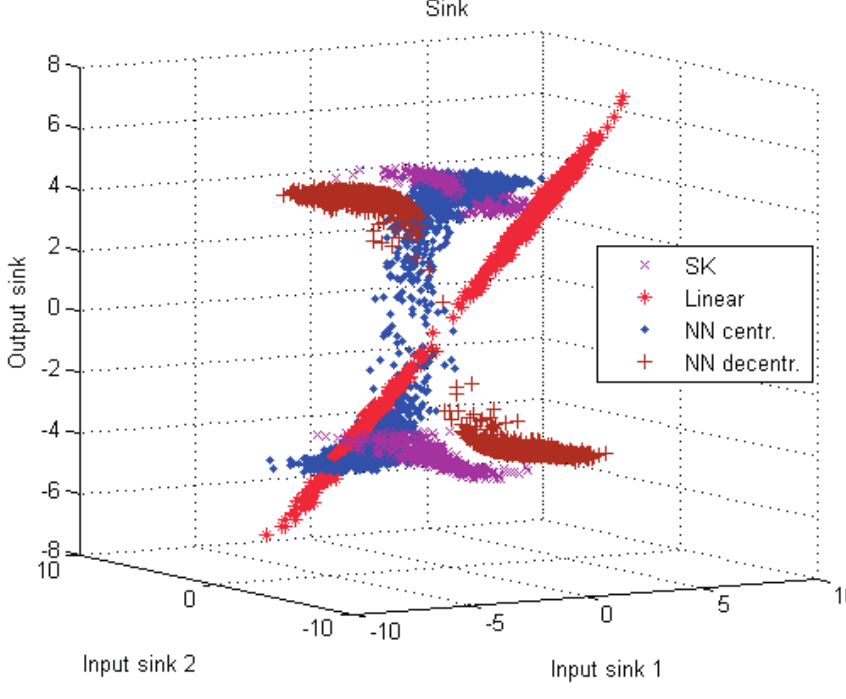
Figure 3. Single source with bimodal distribution: